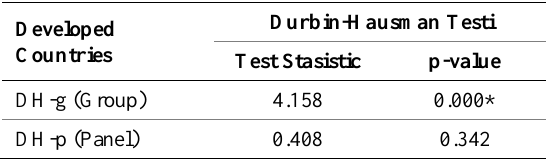
Table 6: Durbin-Hausman Panel Cointegration Test Analysis Results